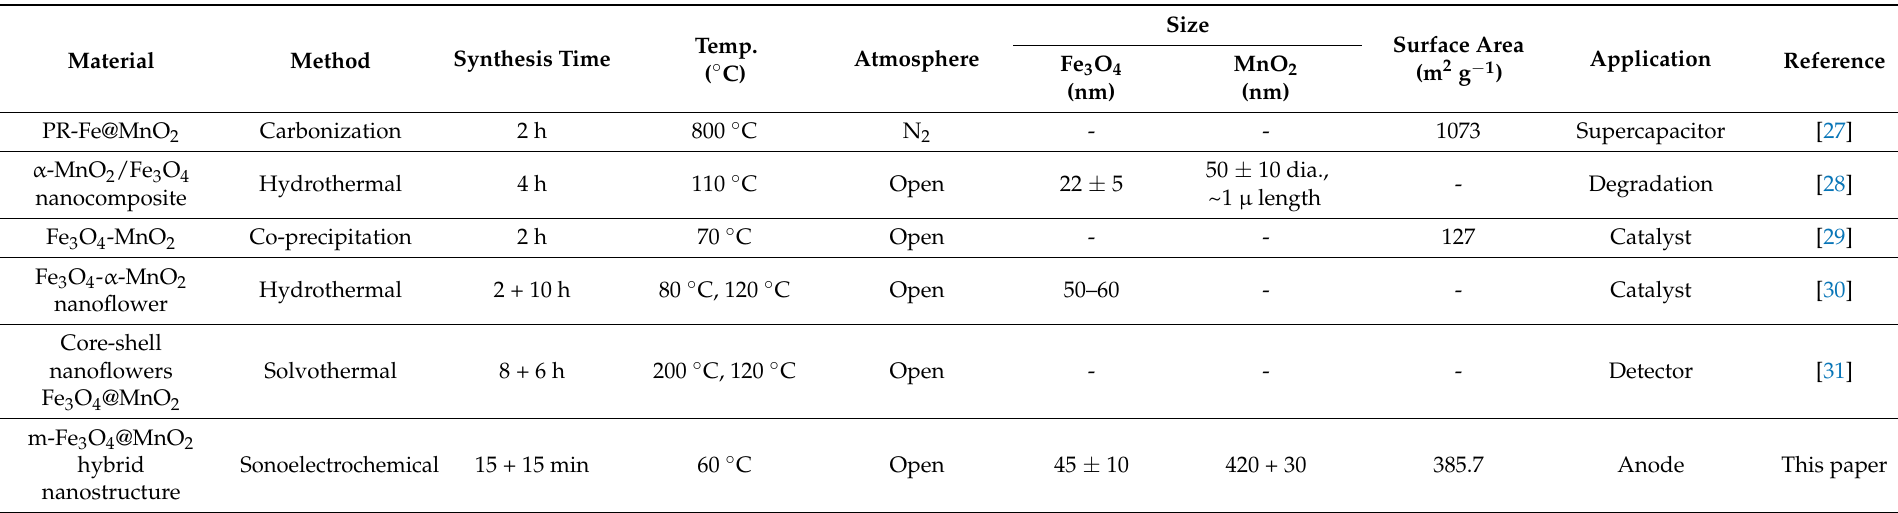
Table 1. Comparative data of various synthesis methods for Fe 3 O 4 @MnO 2 nanocomposite with the current